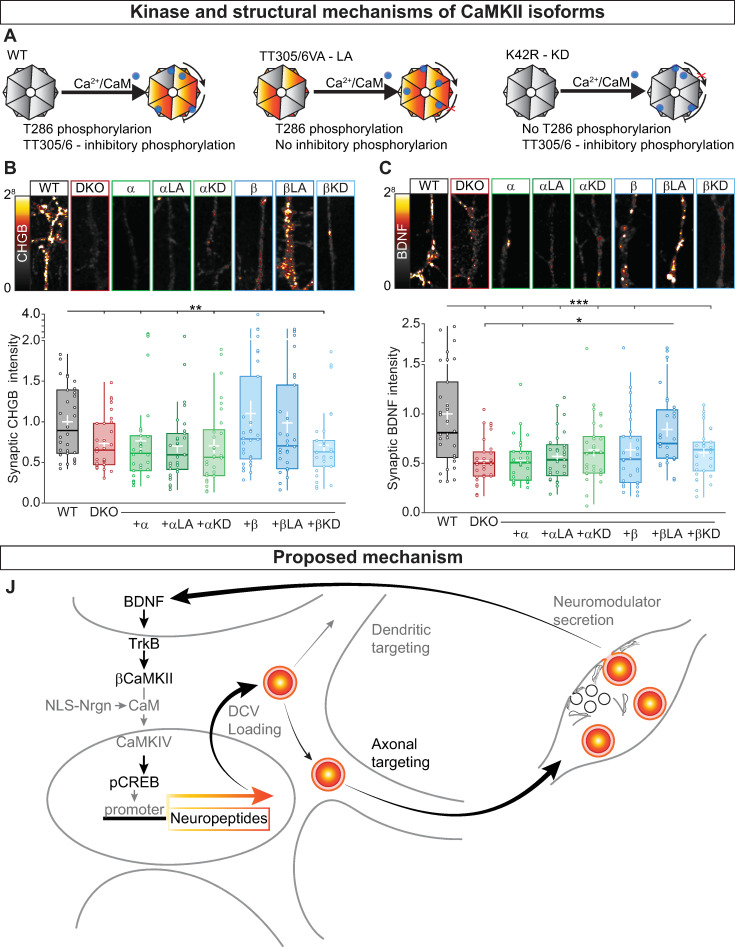
CaMKII activity controls neuropeptide levels.β (A) Schematic representation of WT αCaMKII (left) with Ca/CaM-induced autophosphorylation of T286 triggering the activity of the kinase. The TT305/306VA mutation (middle) inhibits TT305/6 inhibitory phosphorylation leading to an LA form of the kinase. The K42R mutation (right) does not allow T286 autophosphorylation producing a KD CaMKII. For βCaMKII, the mutations are TT306/307VA and K43R for the LA and KD, respectively. (B) Top, typical neurites immunostained for the endogenous DCV marker CHGB; bottom, quantification of synaptic CHGB intensity levels at VGLUT1 positive synapses for DKO and DKO rescued with the indicated constructs normalized to WT. (C) Top, typical neurites immunostained for endogenous BDNF; bottom, quantification of synaptic BDNF intensity levels at VGLUT1 positive synapses for DKO and DKO rescued with the indicated constructs normalized to WT. (D) Schematic representation of the mechanism for CaMKII- and BDNF-dependent gene expression. BDNF binds to TrkB receptors; BDNF-TrkB binding leads to activation of βCaMKII that triggers a downstream pathway leading to Ca/CaM to enter into the nucleus and activating CaMKIV, which in turn phosphorylate CREB at S133. Neuropeptides and neuromodulator are then loaded into DCVs and targeted to dendrites and synapses, where they will fuse with the plasma membrane releasing their content. This mechanism will create a positive feedback loop to regulate neuromodulators content. Boxplots with 95% CI whiskers, white cross shows mean ± SEM. Columns and dots represents individual litters and neurons, respectively. The presented data can be found in S1 Data. *p < 0.05, **p < 0.01, ***p < 0.001. Scale bar = 10 μm (B and D). Ca/CaM, Ca2+/Calmodulin; CaMKII, Ca2+/calmodulin-dependent kinase II; CaMKIV, Ca2+/calmodulin-dependent kinase IV; CHGB, chromogranin B; CI, confidence interval; CREB, cAMP-response element binding protein; DCV, dense-core vesicle; DKO, double-knockout; KD, kinase-dead; LA, long-active; NLS-Nrgn, nuclear-localized neurogranin; SV, synaptic vesicle; Syn1, synapsin1; TrKB, tyrosine receptor kinase B; VAMP2, vesicle-associated membrane protein 2; VGLUT1, vesicular glutamate transporter 1; WT, wild type.